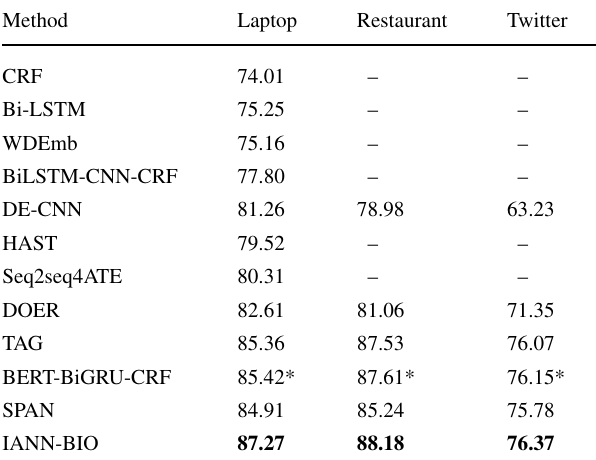
Table 4 The F1 values of the baselines and the proposed